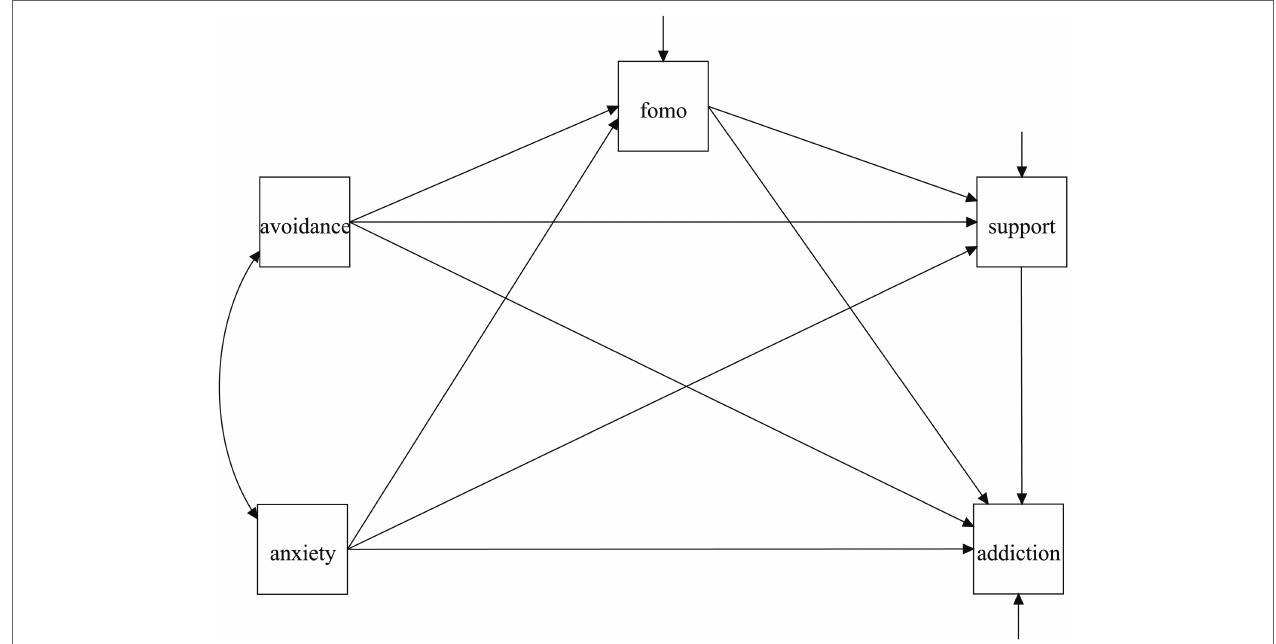
FIGURE 1 | The hypothesized model of present